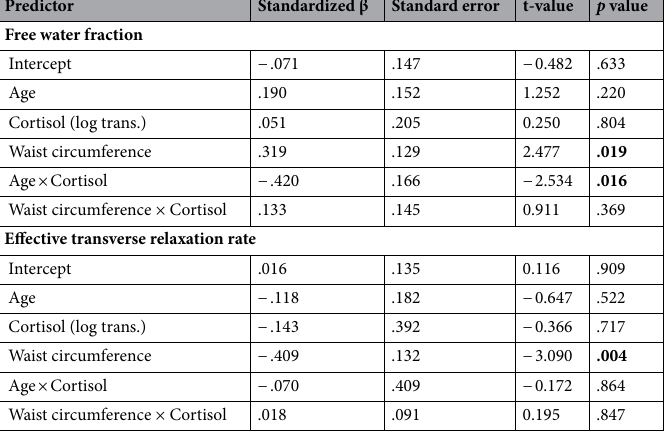
Table 4. Results of two robust multiple linear regression analyses predicting free water fraction (top) and effective transverse relaxation rate (iron content, bottom) in the anterior–superior hypothalamus. Significant values are in [bold].